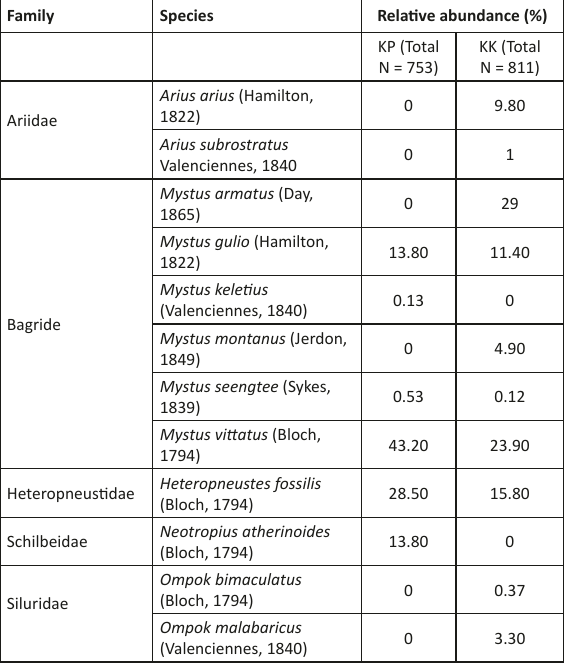
Table 1. Distribution of fish species and their relative abundance in two districts